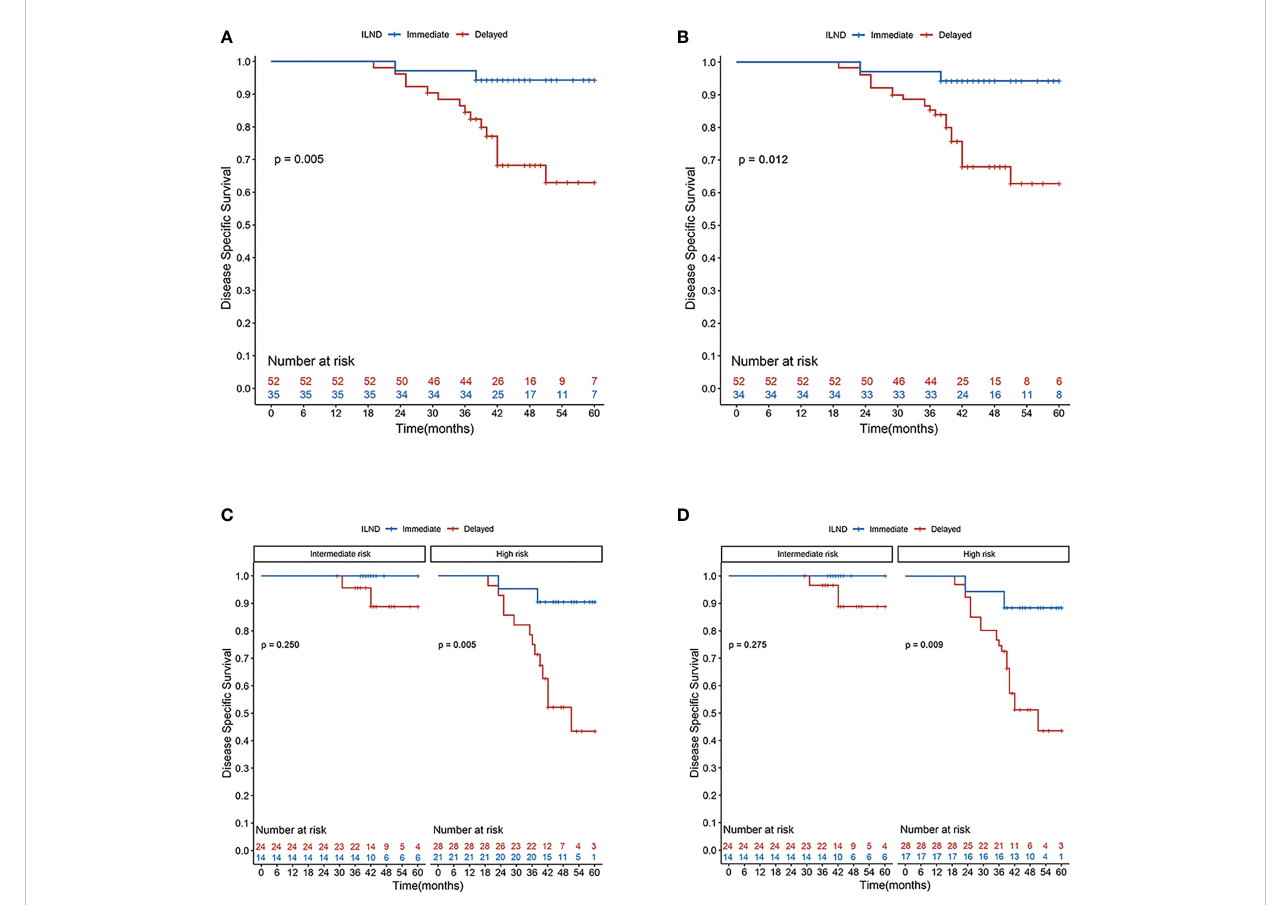
FIGURE 2 Disease-speci fi c survival rates according to Kaplan – Meier curves in patients undergoing immediate (blue line) and delayed (red line) inguinal lymph node dissection: (A) primary cohort; (B) cohort after S-IPTW adjustment; (C) primary cohort strati fi ed by risk level; and (D) cohort strati fi ed by risk level after S-IPTW adjustment.